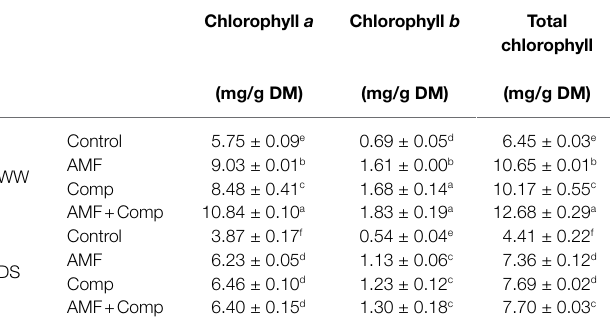
TABLE 4 | Leaf chlorophyll content of non-amended and non-inoculated quinoa (control) and quinoa inoculated with arbuscular mycorrhizal fungi (AMF) and/or amended with compost (Comp) subjected to different water regimes (WW; well- watered or DS: drought stress) after 4 months of